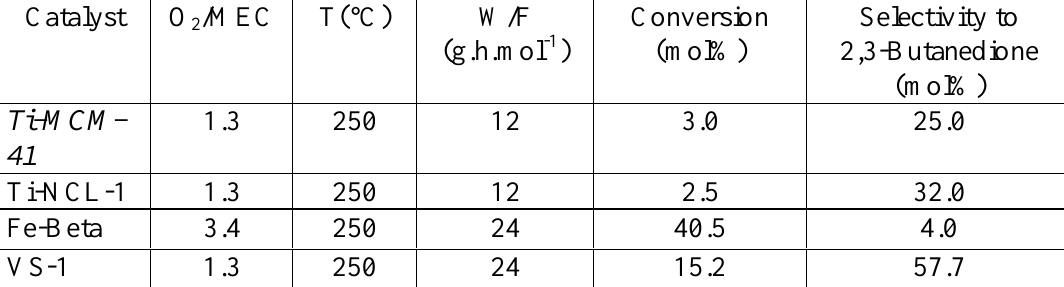
, over zeolites at different reac- 2